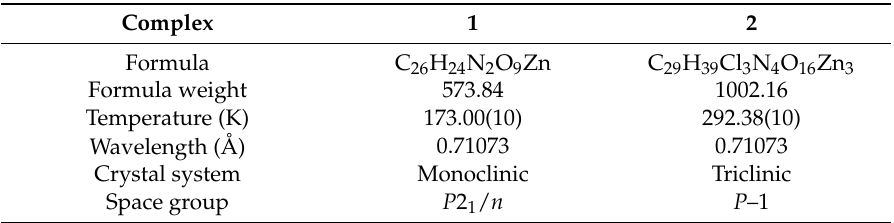
Table 1. Crystal data and structure refinement parameters for complexes 1 and 2